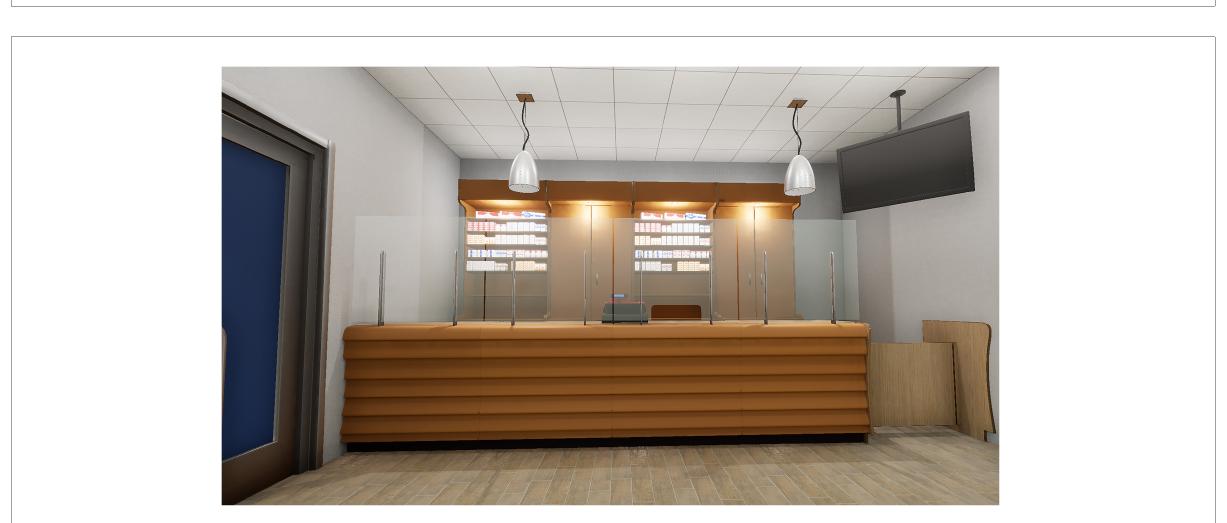
FIGURE3 A tobacco store with cigarette packs.